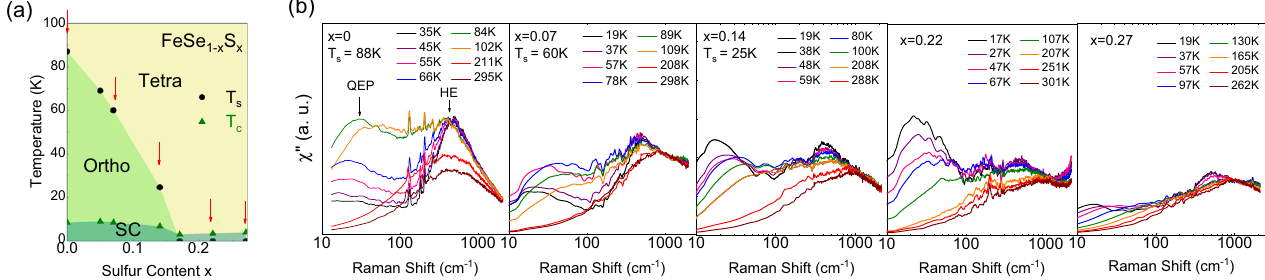
Fig. 1 Raman spectra in the B 1g nematic channel of FeSe 1 − x S x . a Phase diagram of FeSe 1 − x S x . The arrows indicate the compositions whose Raman spectra are shown in ( b ). b Raman response as a function of temperature in B 1g symmetry channel for fi ve different sulfur compositions. The energy is shown on a logarithmic scale. The quasi-elastic peak (QEP) and high-energy peak (HE) are indicated by arrows in the x = 0